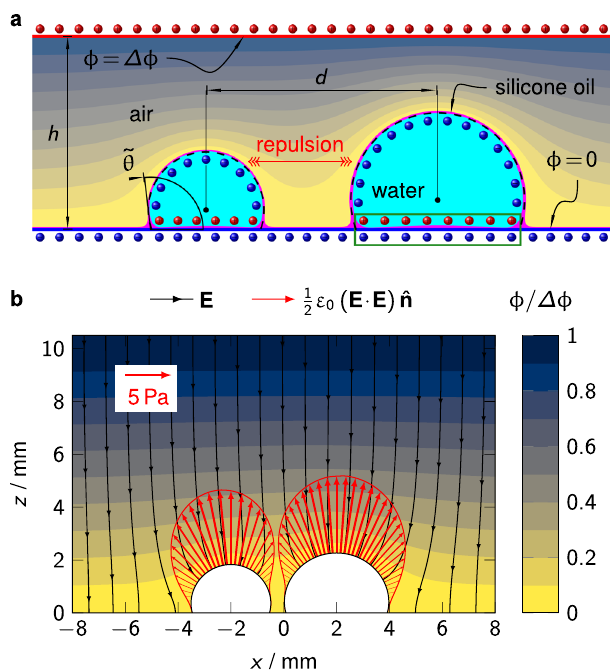
Fig. 3 Origin and magnitude of electrostatic repulsion. Schematic illustration of a presents electrostatic problem and b exemplary numerical solution. a Vertical cross section through the droplets (cyan) along the distance vector d ¼ d ^ d . A thin lubricant fi lm (magenta) cloaks the droplets and forms a small wetting ridge. Between the lower electrode (blue) and upper electrode (red) a potential difference Δ ϕ > 0 is applied. The effective interfaces of the idealized droplets considered in the simulations are symbolized by dashed black lines. The corresponding apparent contact angle is denoted as ~ θ . Red and blue shaded spheres symbolize positive and negative induced surface charges, respectively. The induced surface charges on either side of the idealized footprint, which are encircled by a green rectangle, just compensate each other from a macroscopic point of view. b Cross section ( xz -plane cutting through the centers of the droplets) showing the numerically computed normalized electrostatic potential ϕ / Δ ϕ (colormap) and electric fi eld lines. The applied voltage difference Δ ϕ is 4.5 kV, the droplets have volumes of V 1 = 9.5 μ L (left) and V 2 = 20 μ L (right). The lateral distance between their centers of mass d is 6 mm. The red arrows represent the Maxwell stress acting on the liquid surface. Their length and width scales linearly with the magnitude of the stress. In the upper left corner, a scale for the arrows is provided. The plot shows only a small fraction of the actual computational domain that extends further in lateral the inertial term can be omitted from the balance in Eq. (1). The comparing the effective range of these forces and the minimal measured distance between the droplets, as discussed in the Sup- plementary Methods.